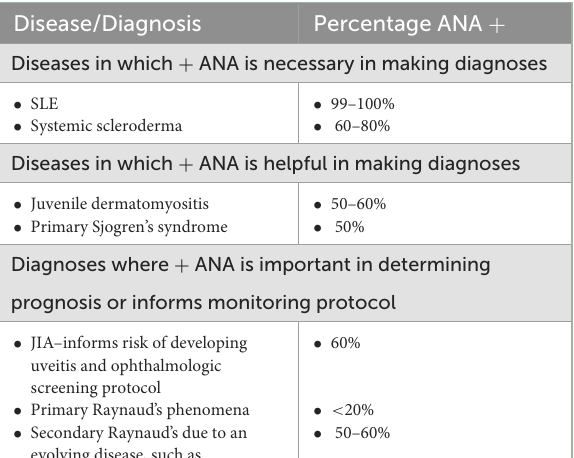
TABLE 1 Positive ANAs in pediatric patients [Adapted from